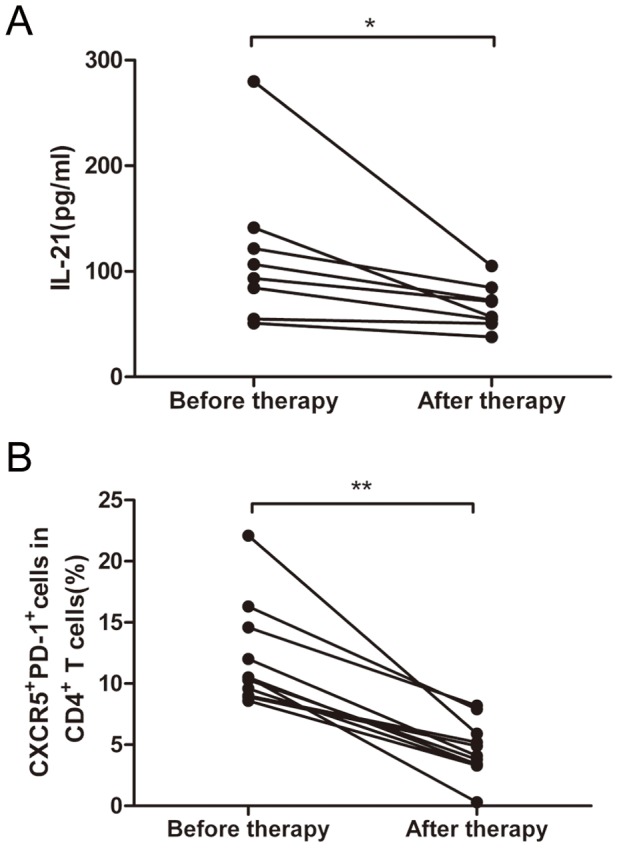
The IL-21 levels and Tfh cells in BP patients before and after therapy.(A) The IL-21 levels of 8 BP patients before and after effective and normative therapy. According to the severity of disease and the whole healty condition, the patients were geiven methylprednisolone for venous transfusion or oral administration and some drugs for external use to prevent infection and promote skin healing. Each data point represents an individual subject before therapy (left) or after therapy (right). (B) The percentage of CXCR5+PD-1+ cells among the CD4+ T lymphocytes of 11 BP patients before and after effective and normative therapy. Each data point represents an individual subject before therapy (left) or after therapy (right). *P<0.05, **P<0.01.